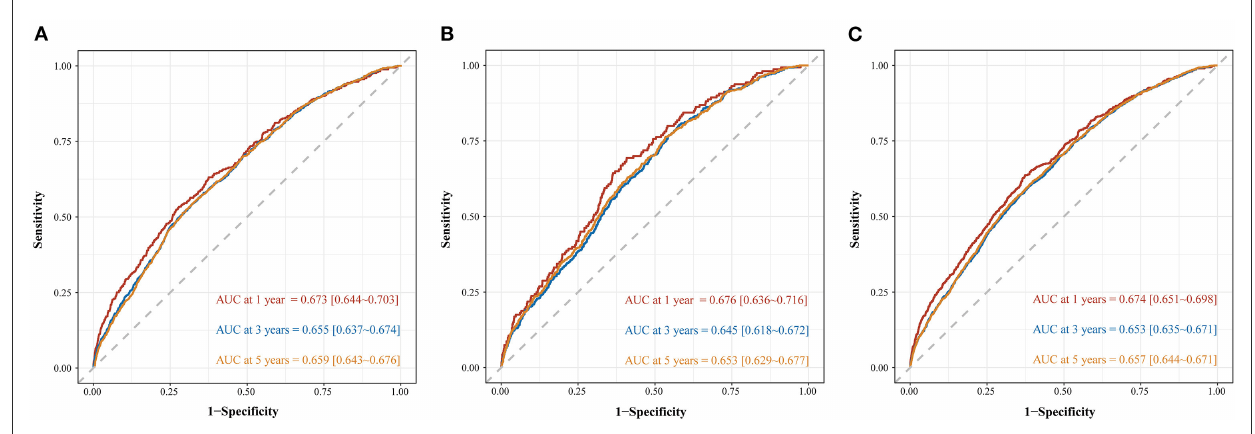
FIGURE3 Time-dependent ROC curve of predicting MACE among patients with ACS in derivation cohort (A) , validation cohort (B) , and full cohort (C) .